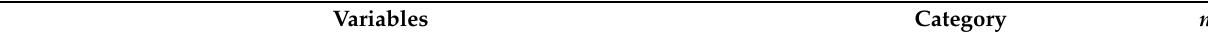
Table 2. Hospice care and LST awareness and preferences among participants ( n = 992).